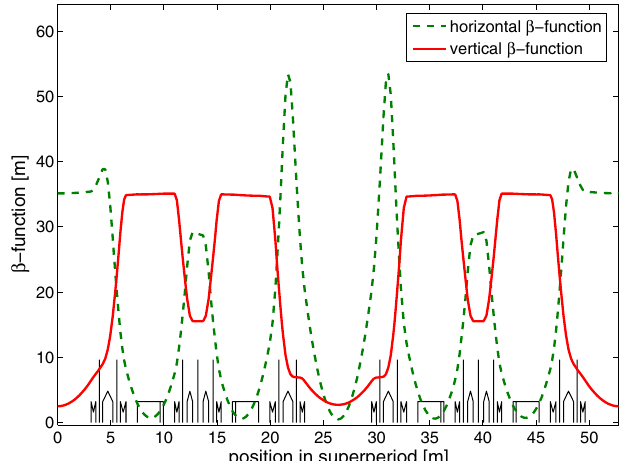
FIG. 1. (Color) The horizontal and vertical beta functions in one superperiod of the ESRF storage ring